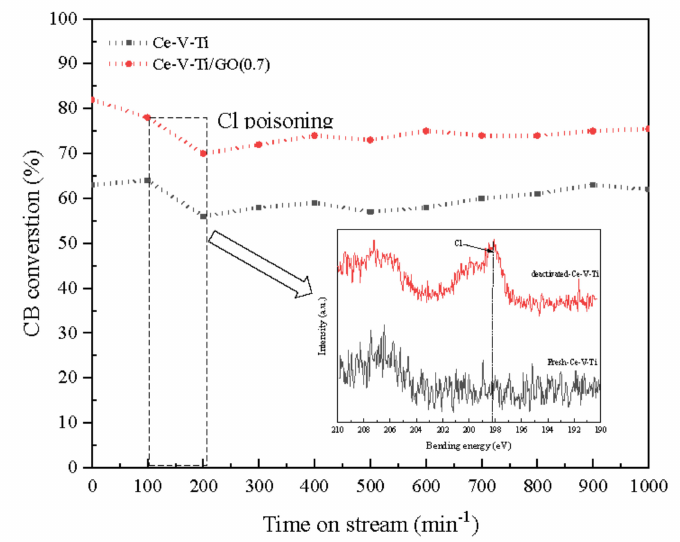
Figure 3. Stability for the CB catalytic combustion over Ce-V-Ti / GO at 200 ◦ C. CB concentration: